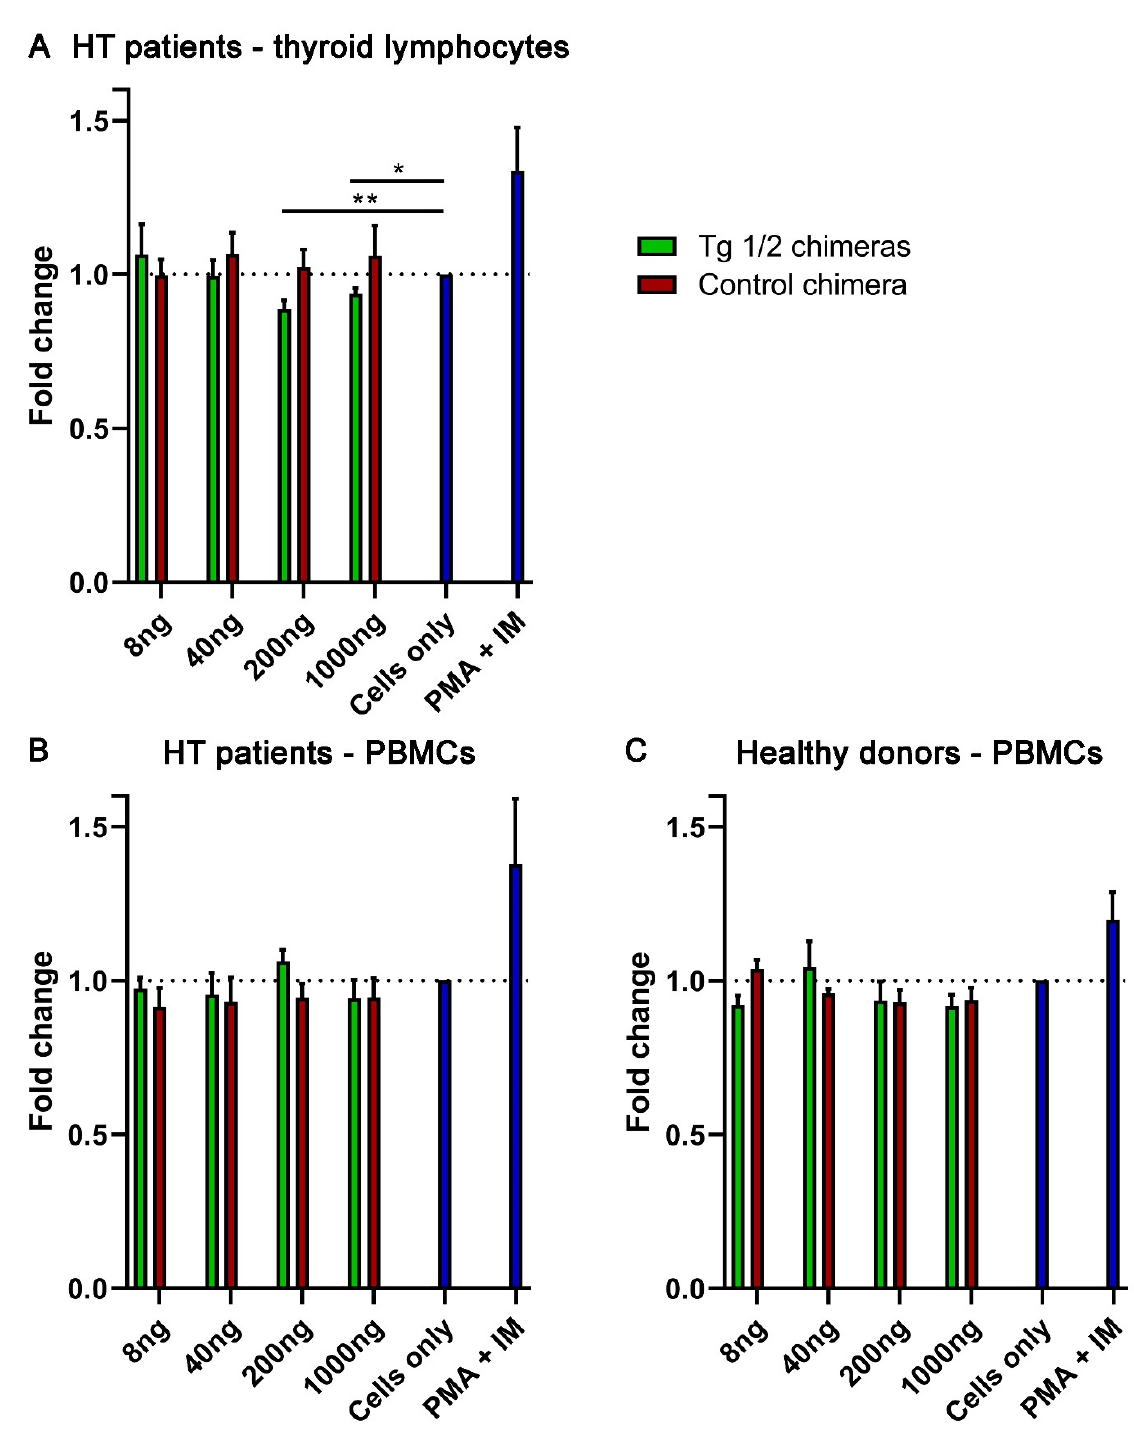
Figure 4. The Tg1/2 chimeras inhibit in vitro the proliferation of TMCs. TMCs ( A ) and PBMCs ( B ) from HT patients or healthy donors ( C ) were co-cultured with rising concentrations of Tg 1/2 chimeras or Control chimera and the cell proliferation was evaluated by MTT assay compared to the untreated cells. All samples were triplicated and average values were used for analysis. Mean ± SD values of fold change were calculated for each group; p -values were calculated (* p < 0.05, ** p < 0.01). Data are representative of 4 independent experiments.